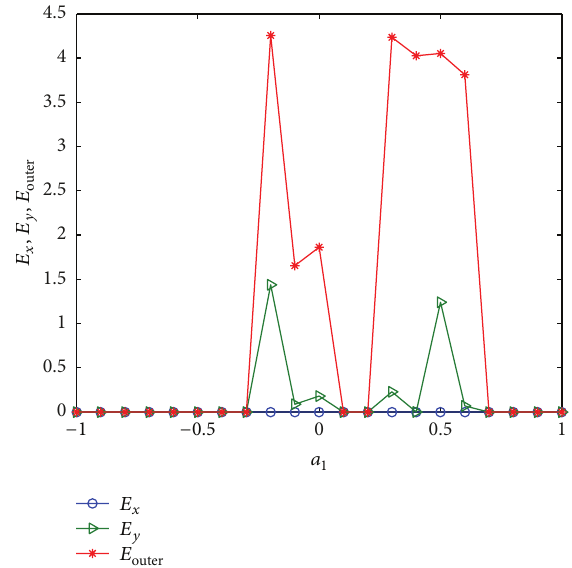
Figure 3: The curves of 𝐸 𝑥 , 𝐸 𝑦 , and 𝐸 with 𝑏 1 = 0.2, 𝑎 2 = 0.5 , and 𝑏 2 = 0.3 and 𝑁 = 10,𝑚 𝑥 = 0.2 , and = 0.3 . 𝑚 𝑦